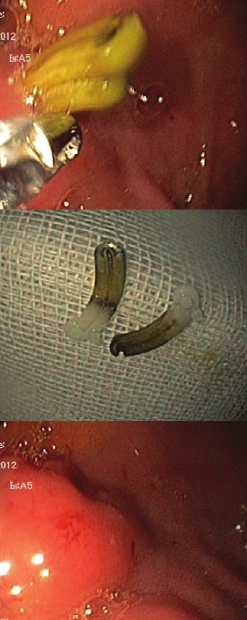
Figure 3: The Hem-o-Lok clips were removed using an Olympus grasping